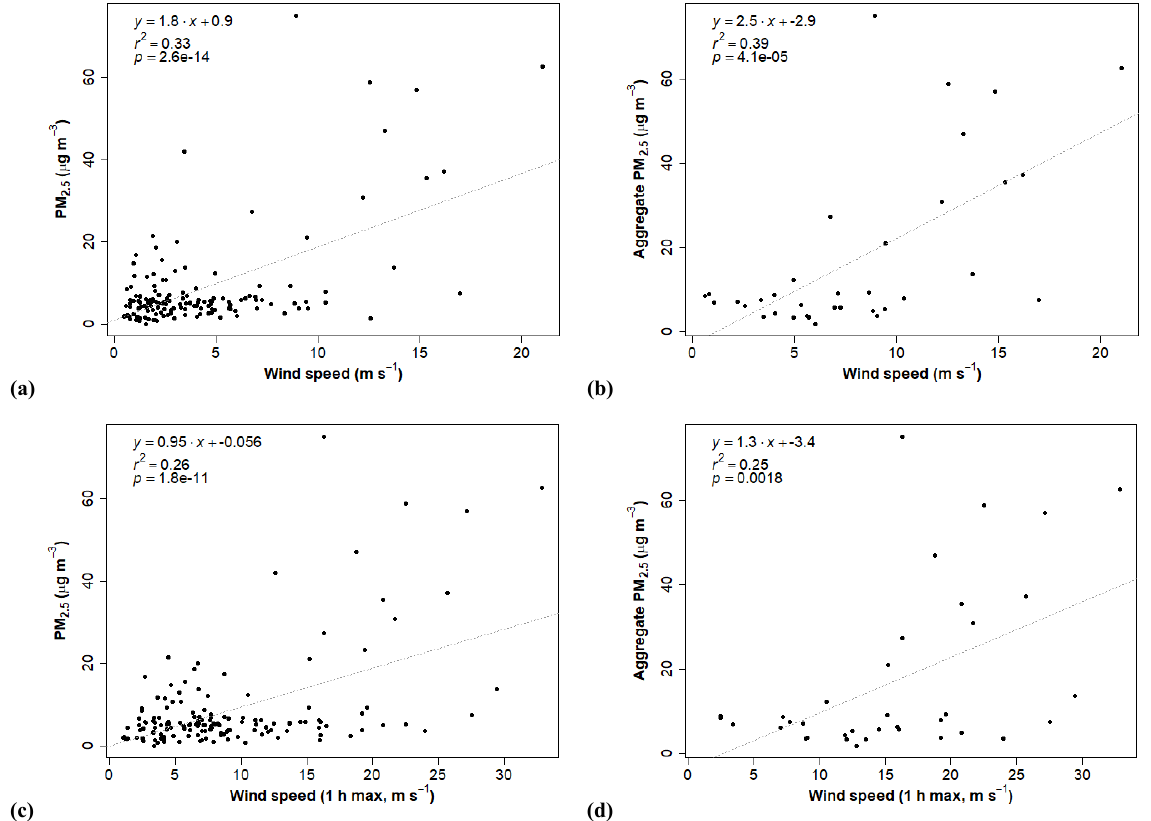
Figure 10. Wind speed (ms − 1 ) and PM 2 . 5 (µgm − 3 ) at PEAV for (a) all data and (b) days with aggregates. Maximum 1h wind speed for (c) all data and (d) days with